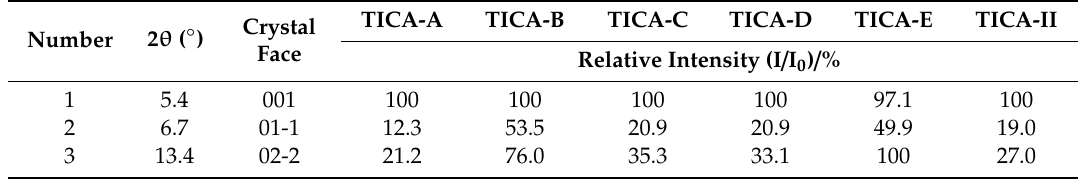
Table 3. The PXRD of TICA crystal habits and calculated from single-crystal di ff raction results. TICA-A TICA-B TICA-C TICA-D TICA-E TICA-II ◦ ) Crystal Number 2 θ ( Face Relative Intensity (I / I 0 ) /